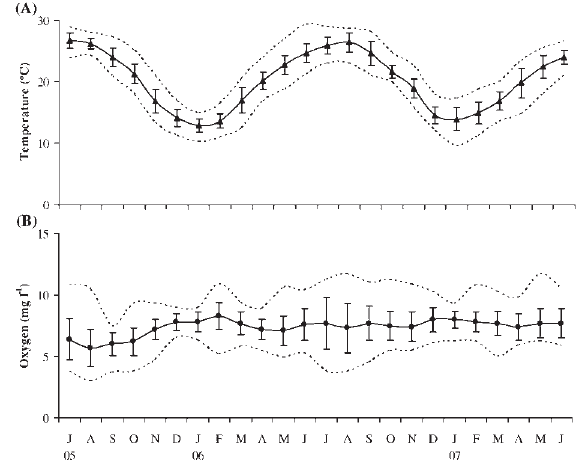
Fig . 3. − Monthly variation in (A) seawater temperature and (B) dissolved oxygen in the earthen pond during the mark-recapture experiments (July 2005 to June 2007). Data presented as mean±SD and range (dashed